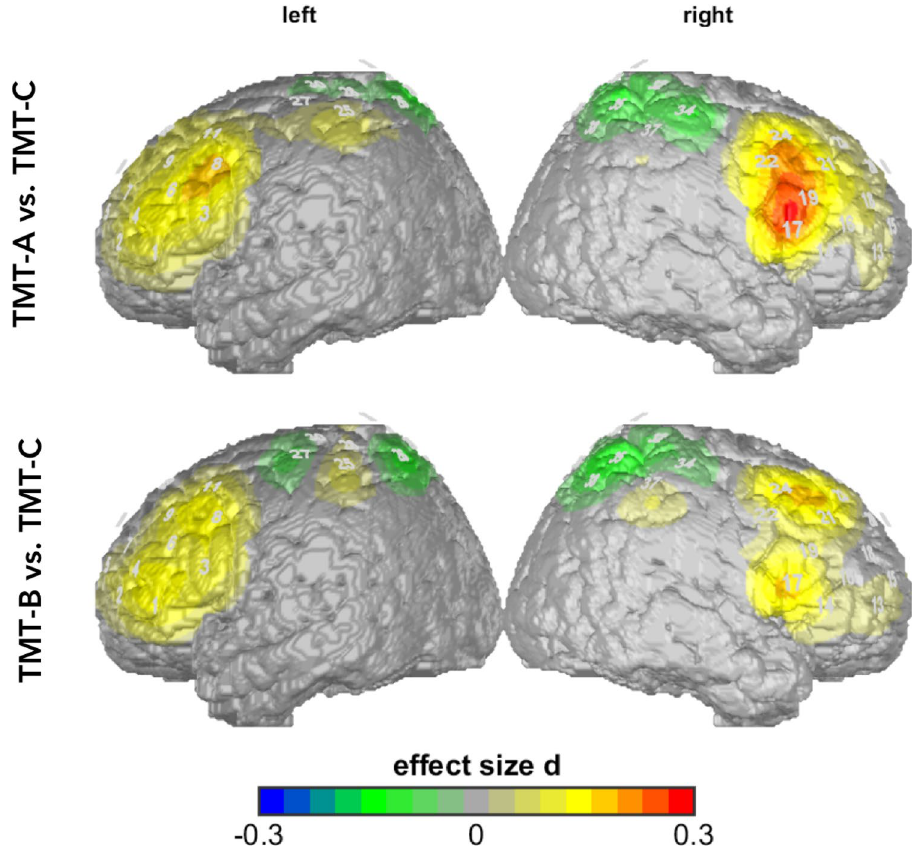
Figure 2. Time-corrected data (uncorrected O 2 Hb values): activity in TMT-A and TMT-B versus TMT-C. Higher activity in TMT-A and TMT-B compared to TMT-C. Differences are shown in effect size Cohen’s